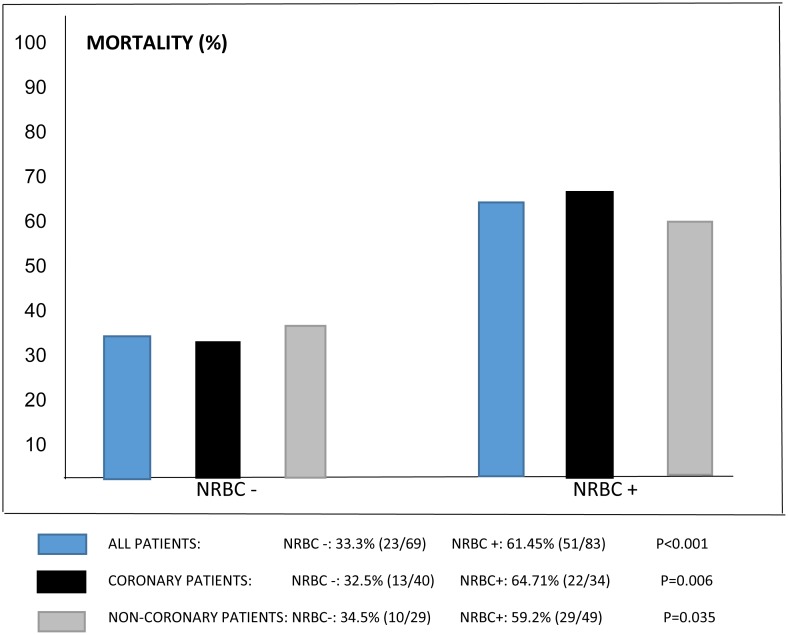
Mortality among coronary and non-coronary patients.